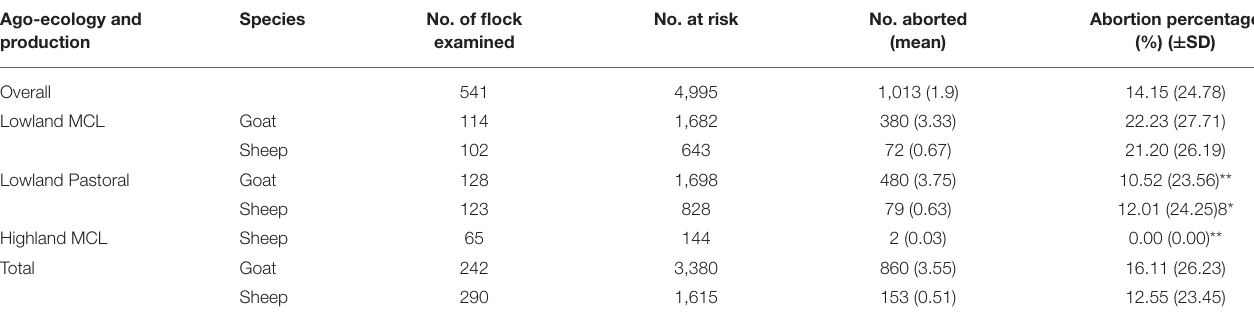
TABLE 2 | Mean annual sheep and goat abortions percentage in three Agroecology and production system of Ethiopia. Ago-ecology and Species No. of flock No. at risk No. aborted production examined